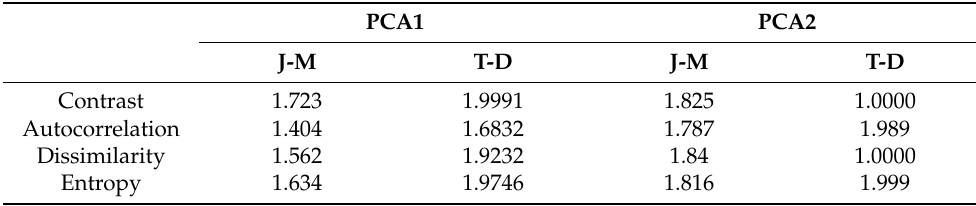
Table 2. Separability of the